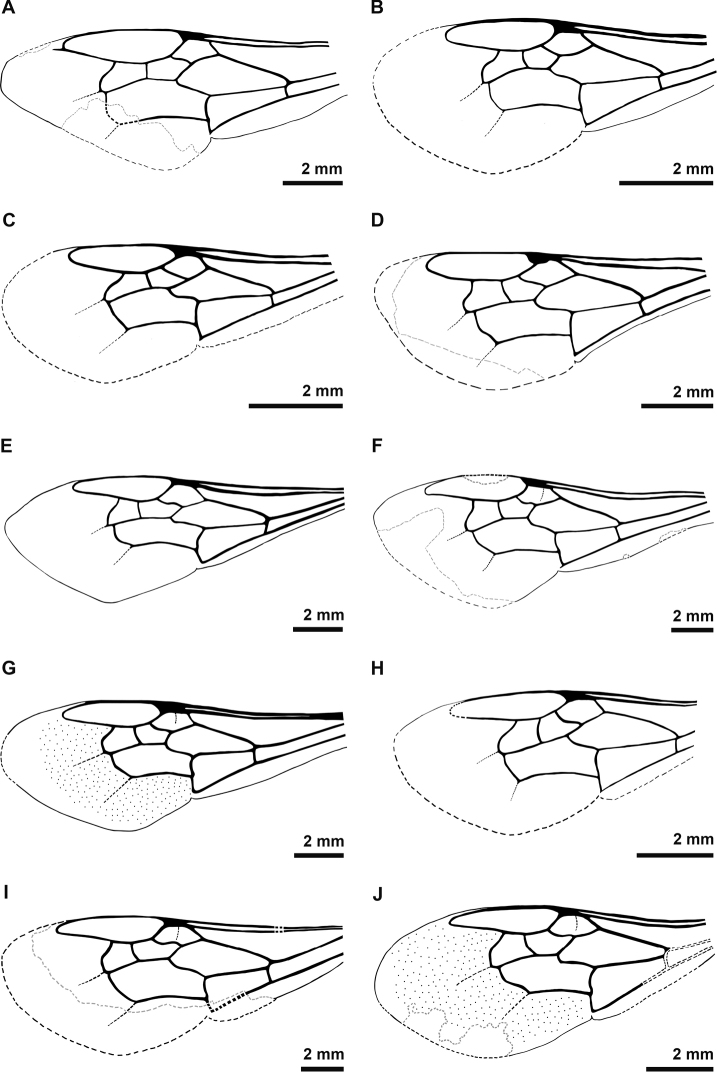
Forewing drawings of the fossil bumble bees studied herein. Some forewings were mirrored to enable comparison across all specimens AOligobombus
cuspidatus (mirrored) B Holotype of Calyptapis
florissantensis (mirrored) CC.
florissantensisDBombus (Paraelectrobombus) patriciae (mirrored) EB. (Mendacibombus) beskonakensisFB. (Cullumanobombus) trophonius (mirrored) GB. (Cullumanobombus) randeckensis (mirrored) HB.
vetustusIB. (Cullumanobombus) pristinus (mirrored) JB. (Melanobombus) cerdanyensis.